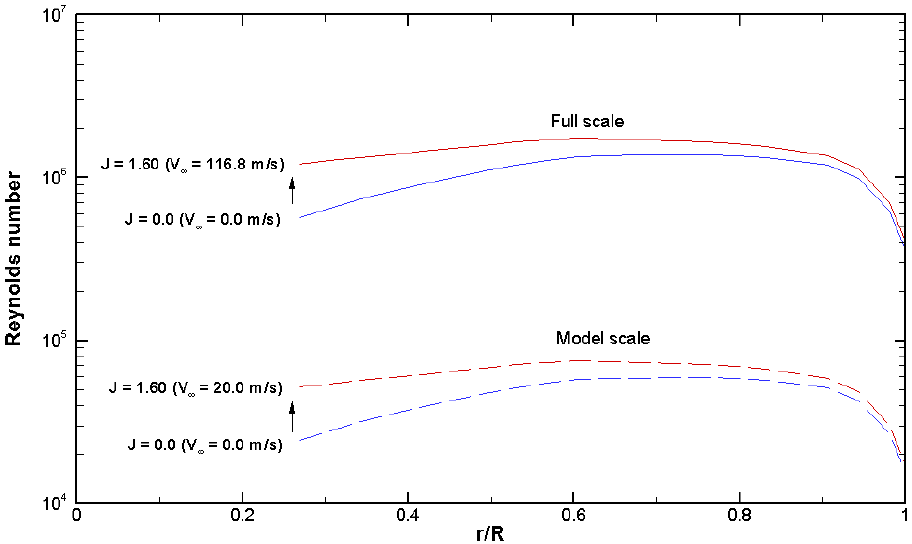
Figure 9. Comparison of the Reynolds number as a function of advancing ratio for full scale and model scale with respect to blade-span direction.